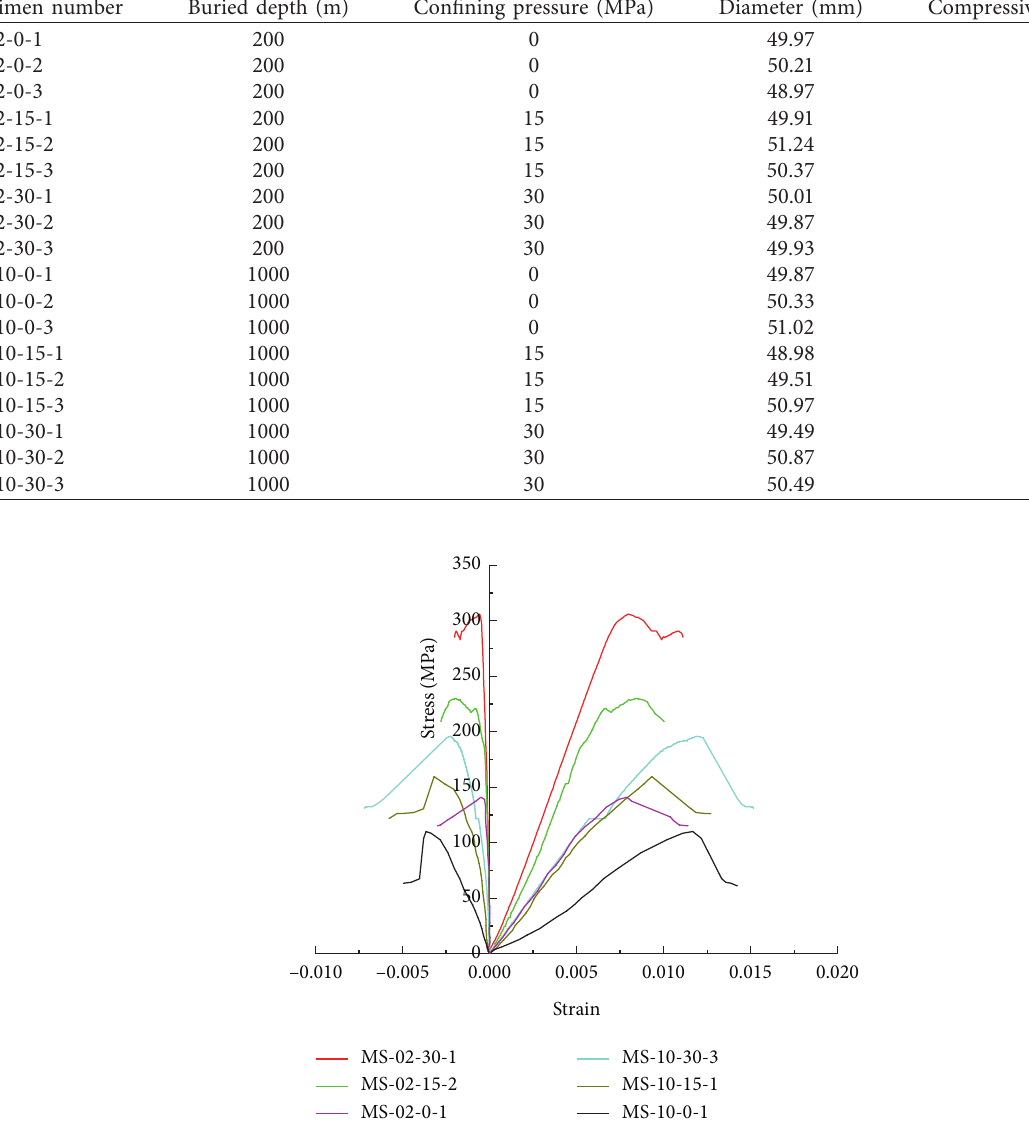
Figure 5: Stress-strain curves of mudstone specimens. Table 2: Quantitative analysis of composition of mudstone based on fluorescence